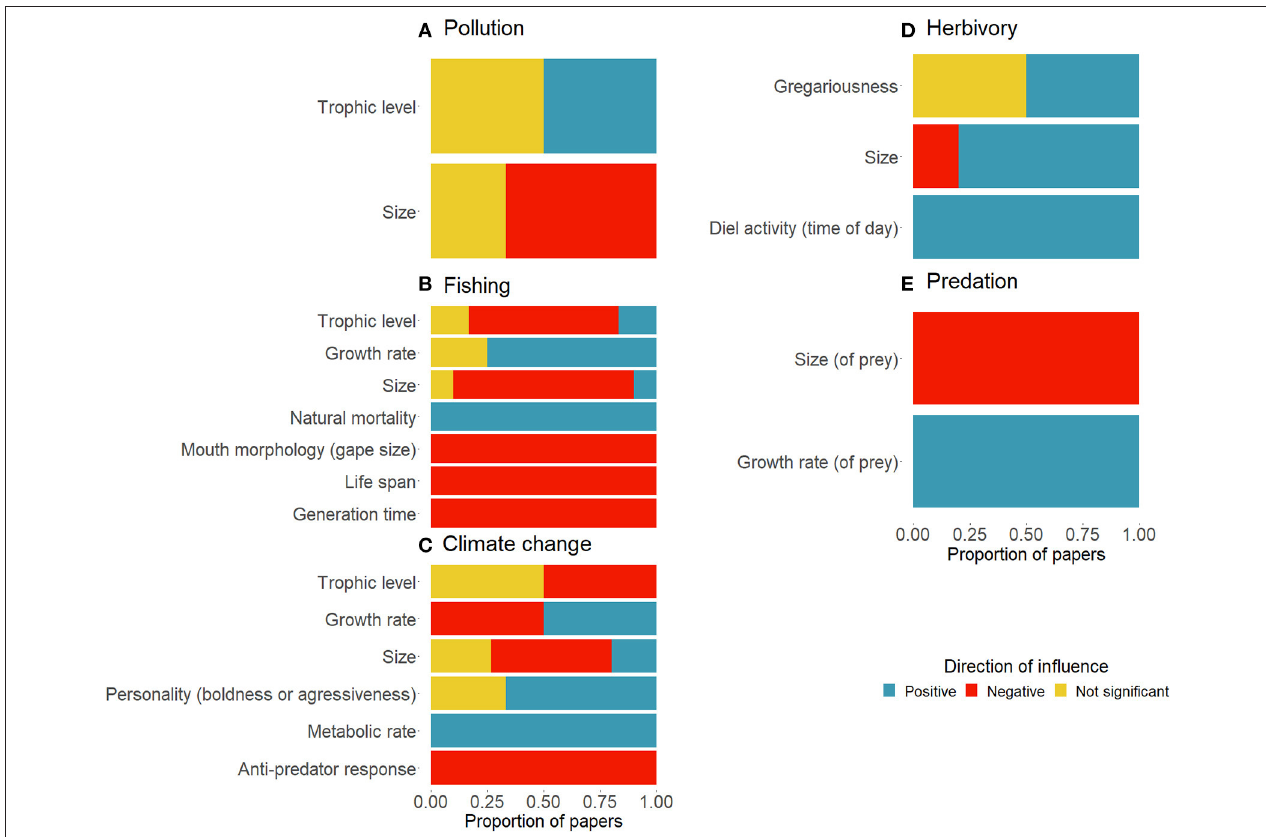
FIGURE 5 | Proportion of papers linking traits positively (blue), negatively (red) or without significance (yellow) to (A) pollution, (B) fishing, (C) climate change, (D) herbivory, and (E)